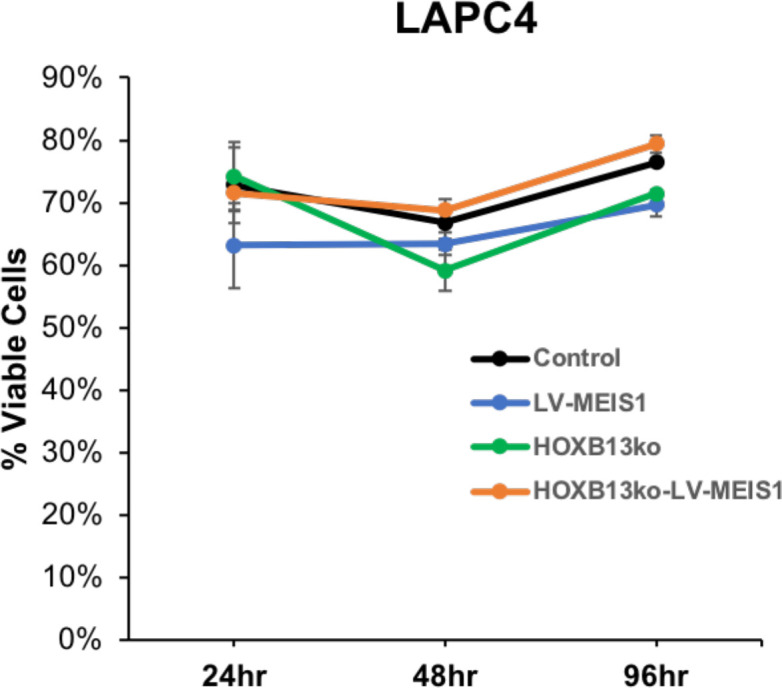
Cell viability is unaffected by HOXB13ko in LAPC4 cells.Cell viability over time of LAPC4-Control, -LV-MEIS1, -HOXB13ko, and -HOXB13ko-LV-MEIS1.